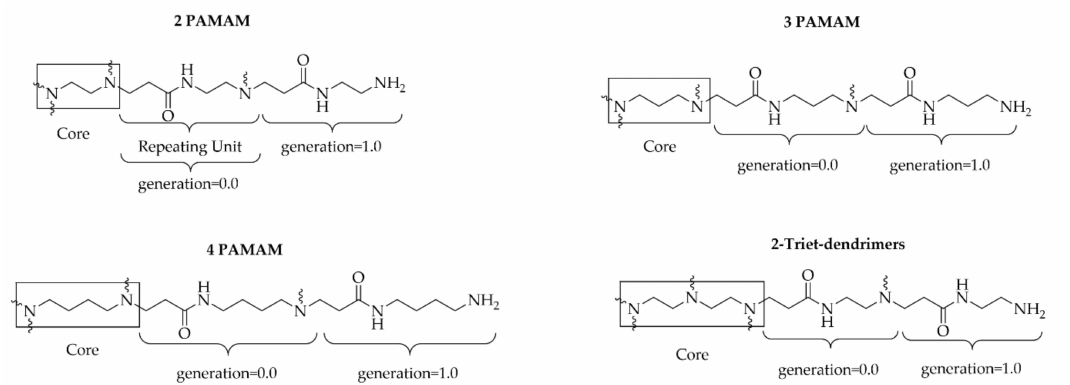
Figure 1. Schematic structure of PAMAM and 2- Triet - dendrimers employed in this